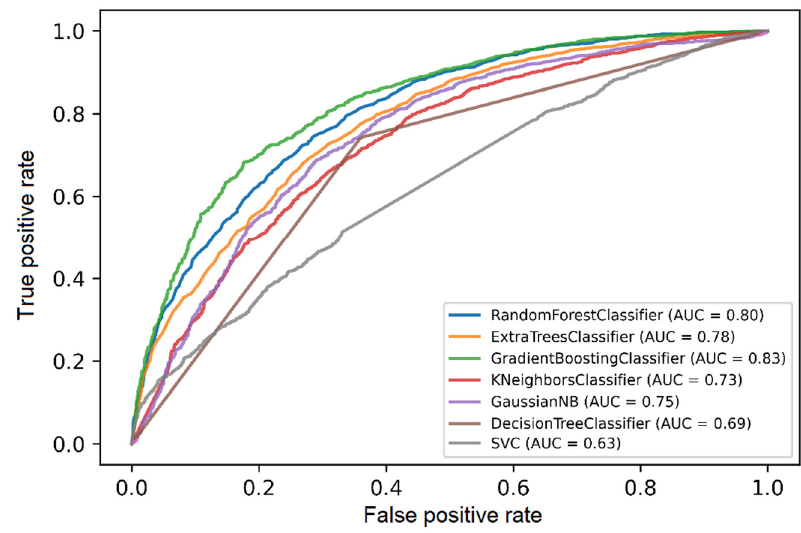
Figure 5. ROC curves of the different classifiers for an arbitrary participant.